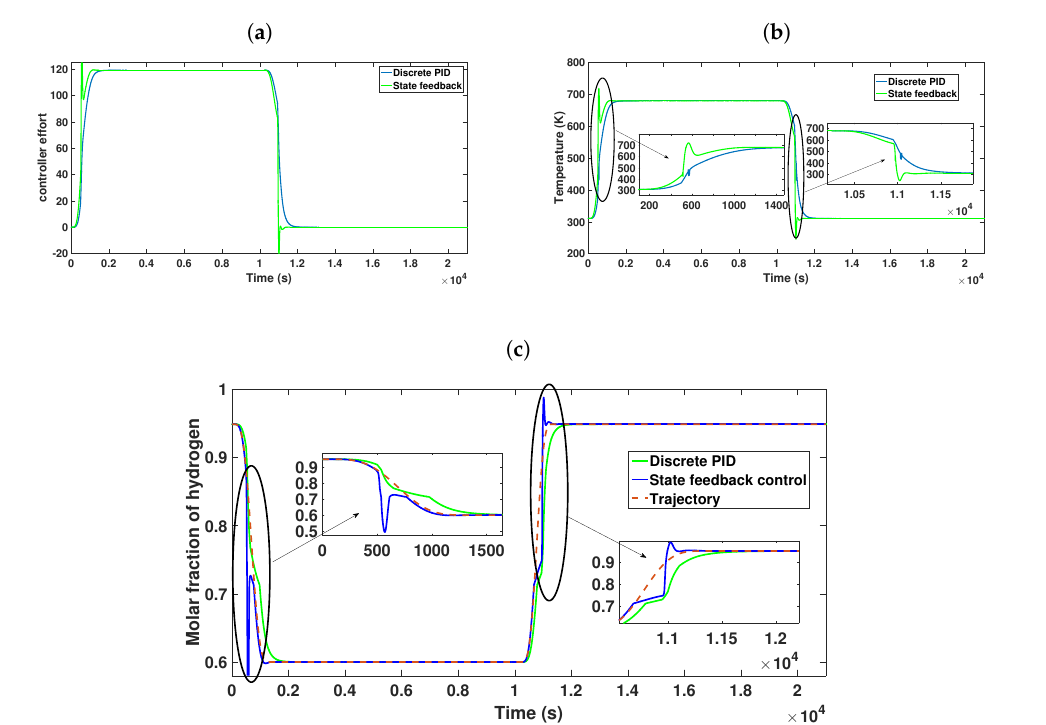
Figure 13. Control signals to reach different purity values and verify the performance of the con- trollers. ( a ) Control signals generated before the block of inverse input functions. ( b ) Control signals generated using the input inverse functions’ block. ( c ) Hydrogen purity obtained from 3 trajec- tory changes.